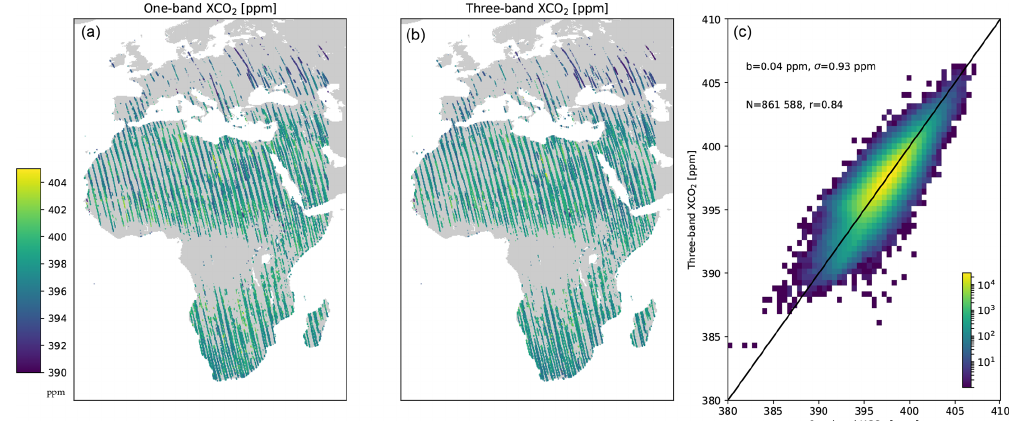
Figure 6. X CO 2 distributions over the EMEA regions from one-band (a) and three-band (b) retrievals in the time period between 8 September and 31 December 2014. In (c) corresponding X CO 2 retrievals from one-band and three-band retrievals are shown with bias ( b ), standard deviation ( σ ), and Pearson correlation coefficient ( r ). Here, a mean bias of 0 . 88ppm was subtracted from three-band